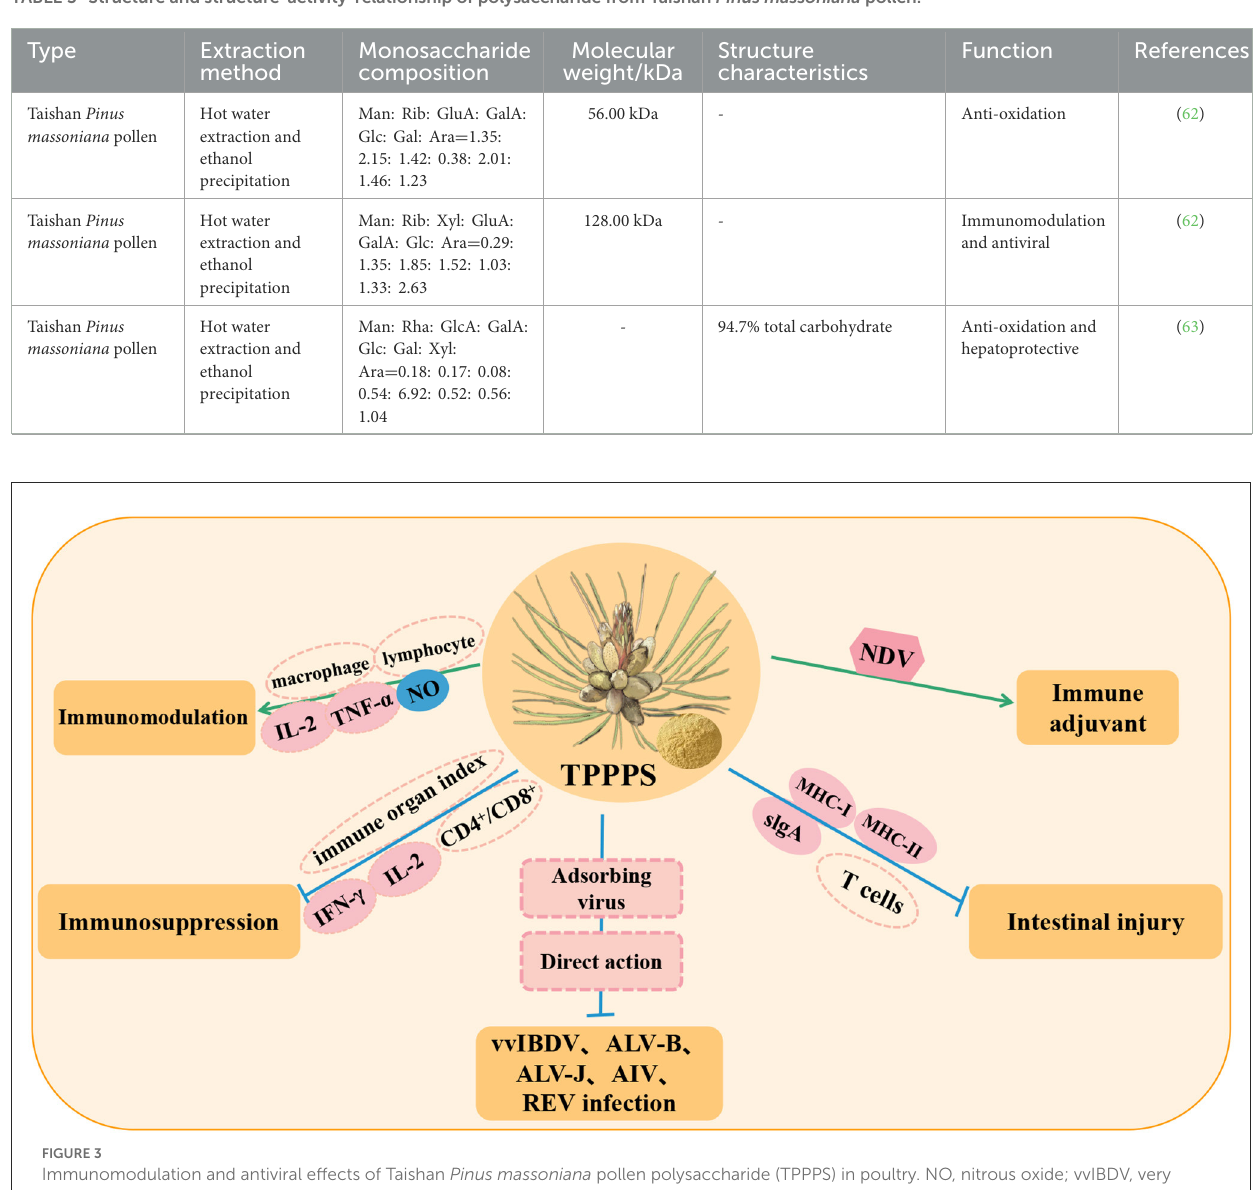
FIGURE3 Immunomodulation and antiviral effects of Taishan Pinus massoniana pollen polysaccharide (TPPPS) in poultry. NO, nitrous oxide; vvIBDV, very virulent infectious bursal disease virus; ALV-B, avian leukosis virus subgroup B; ALV-J, subgroup J avian leucosis virus; AIV, avian influenza virus; REV, reticuloendotheliosis virus; MHC-I, major histocompatibility complex class I; MHC-II, major histocompatibility complex class